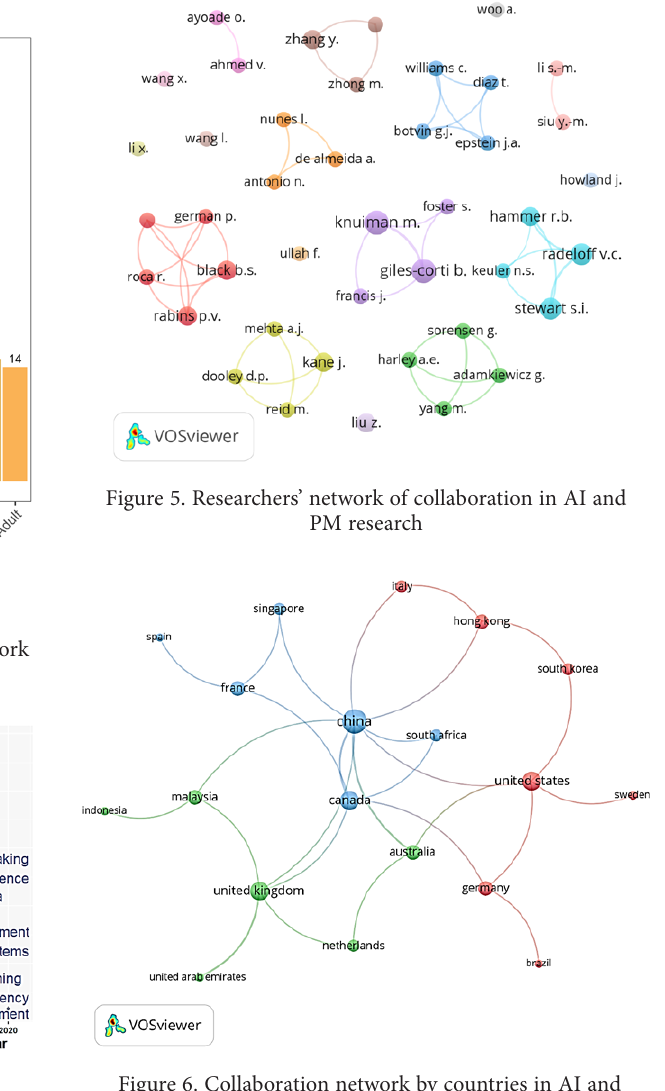
Figure 4. Trend topic of AI and PM research